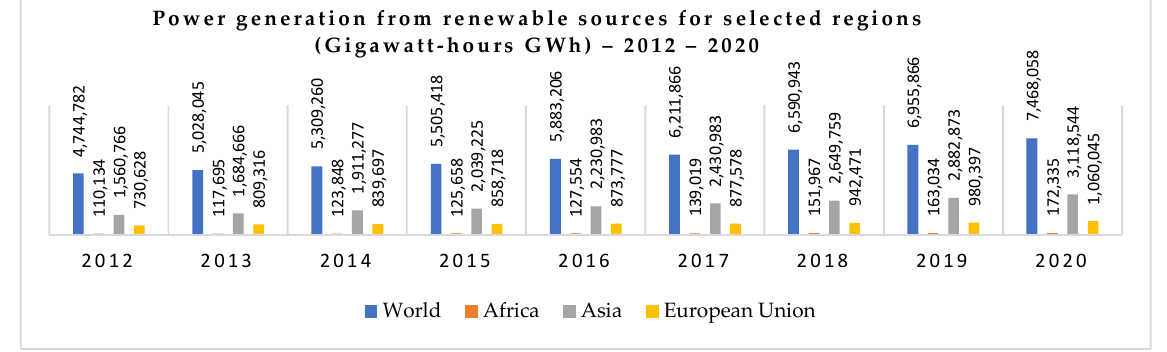
Figure 3. Actual power generation from renewable sources for selected regions (Gigawatt hours GWh)—2012–2020. Source: the authors centralized and adapted data published by ref. [177].